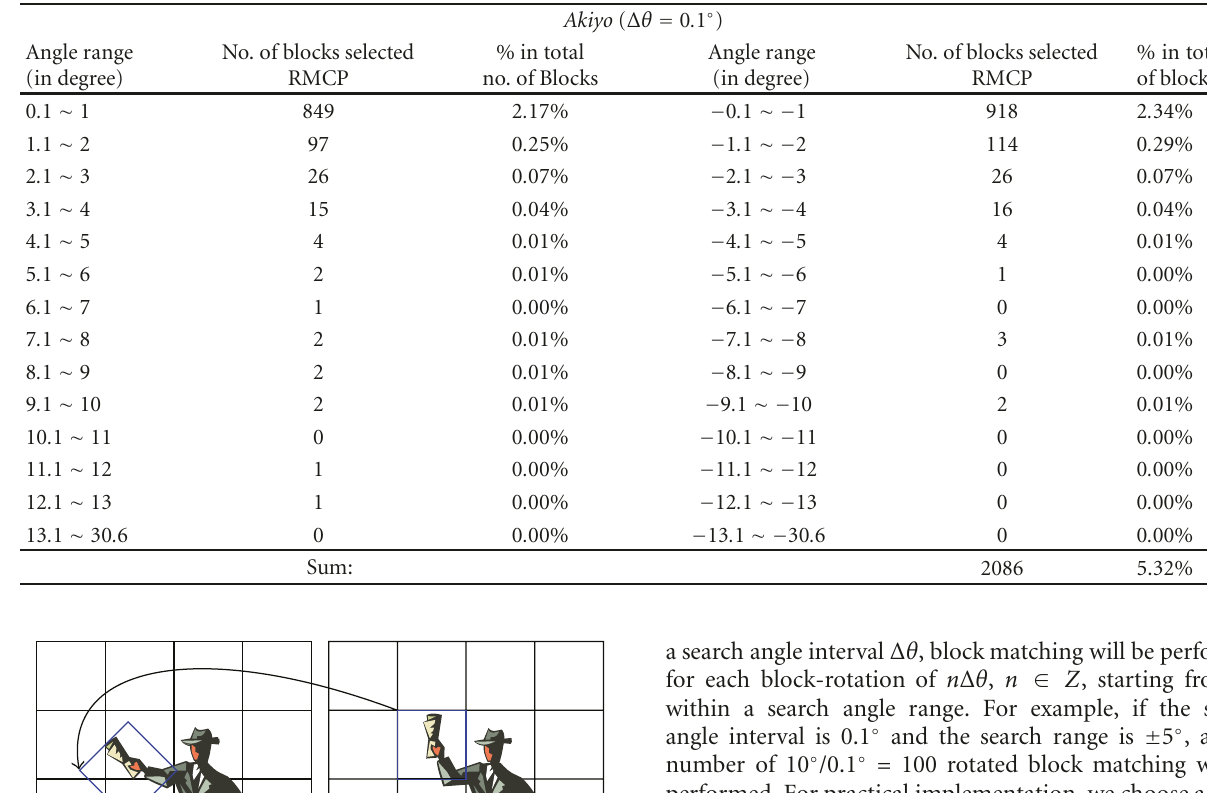
Table 3: Rotation angle distribution in sequence Akiyo .